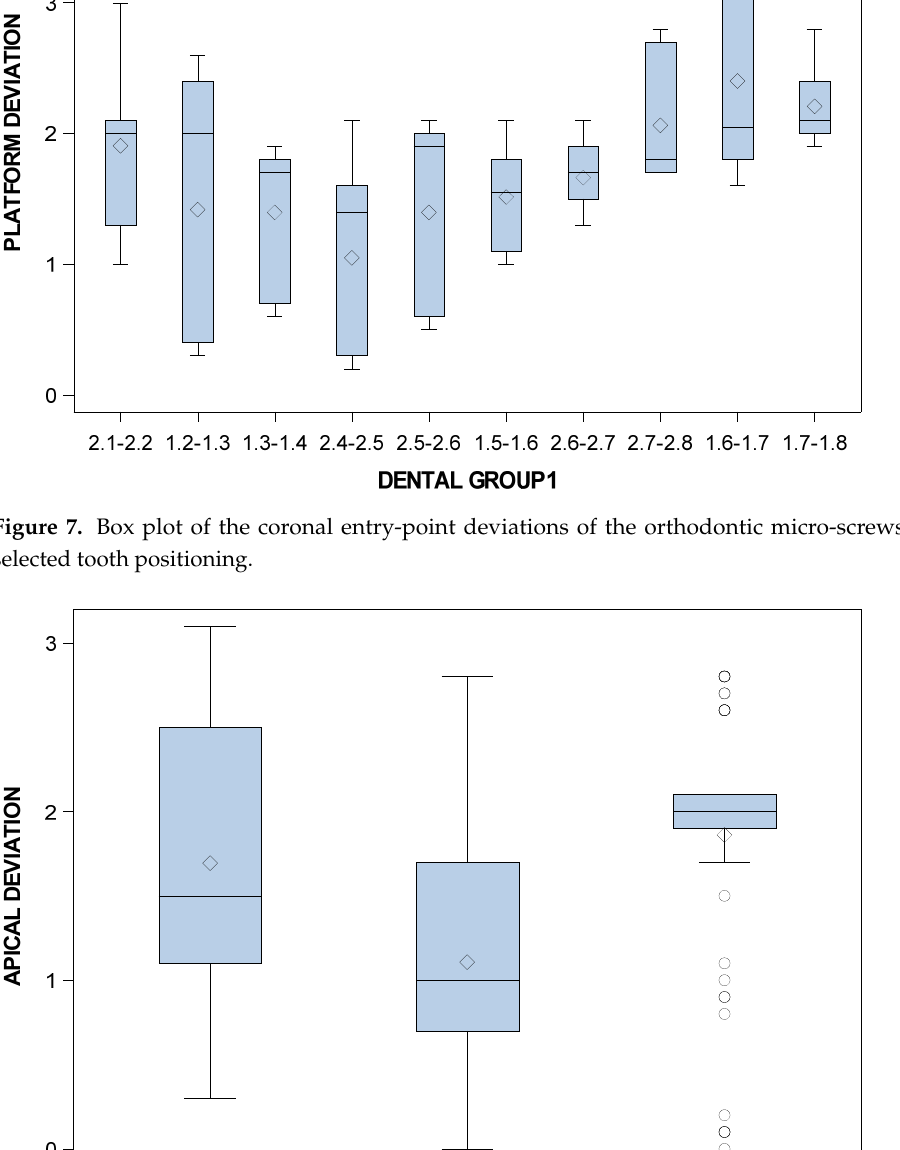
Figure 7. Box plot of the coronal entry-point deviations of the orthodontic micro-screws in the selected tooth positioning.